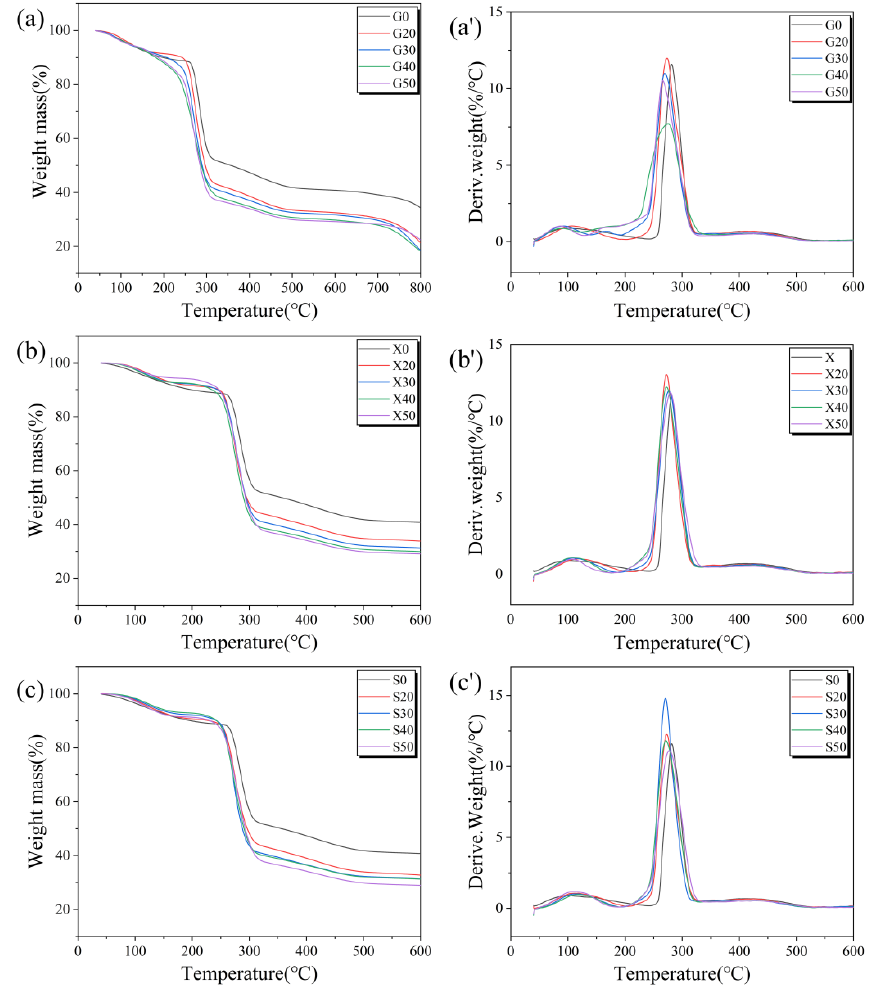
Figure 3. TG and DTG curves of the funoran films with different additions of G ( a , a’ ), S ( b , b’ ), and X ( c , c’ ).